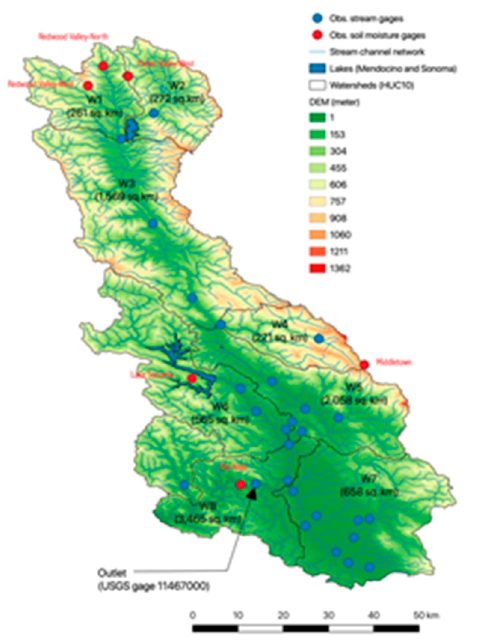
Figure 3. Total precipitation and characteristics of the Russian River basin. Watersheds (referred to as “W”) indicate the hydrologic unit code 10 determined by the United States Geological Survey (USGS).